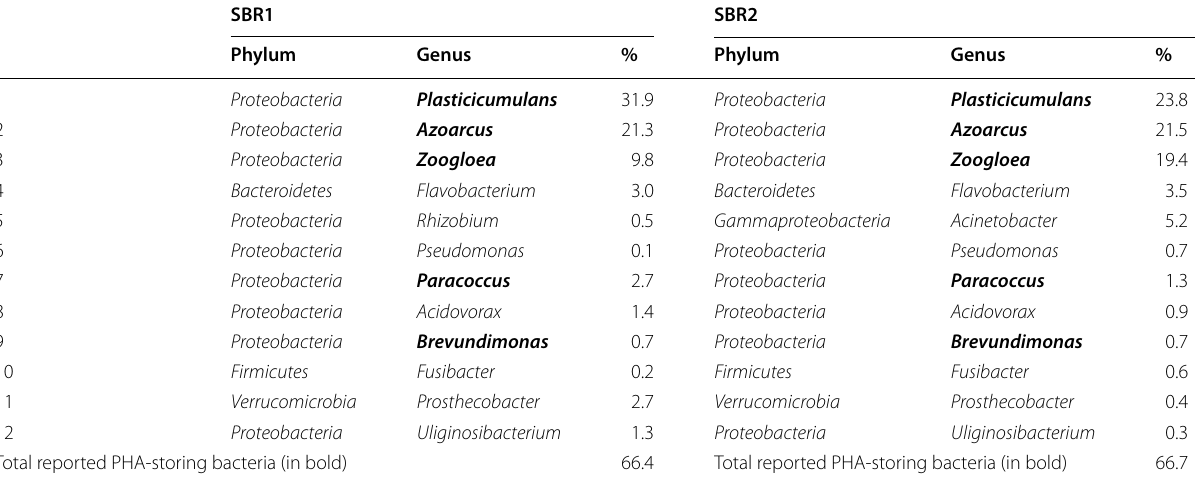
Table 1 The 12 most abundant bacteria identified by high throughput sequencing in the two SBRs under stable